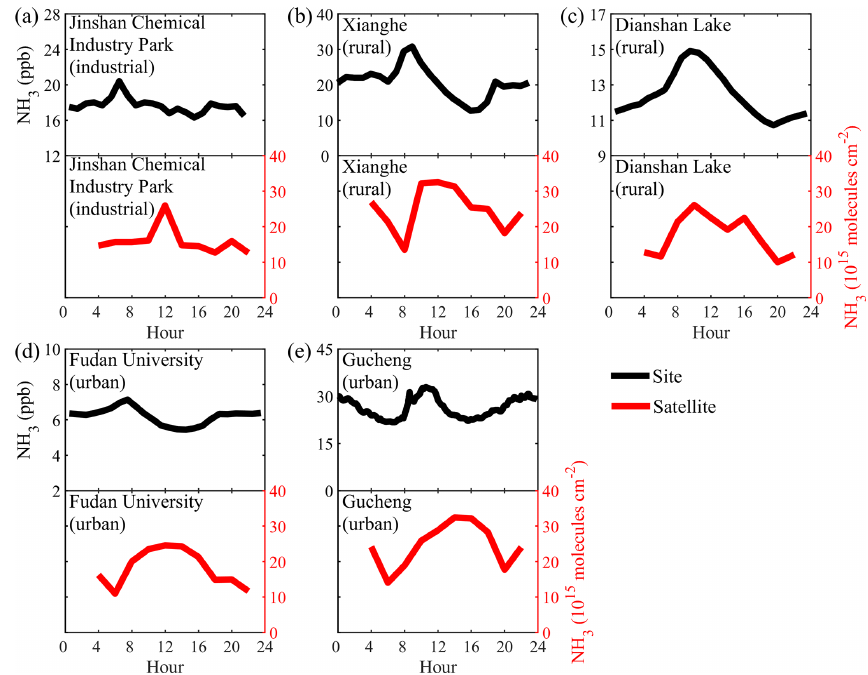
Figure 2. GIIRS-based and measured hourly NH 3 concentrations at five sites: Jinshan Chemical Industry Park (JSP, a ), Xianghe (XH, b ), Dianshan Lake (DSL, c ), Fudan University (FDU, d ) and Gucheng (GC, e